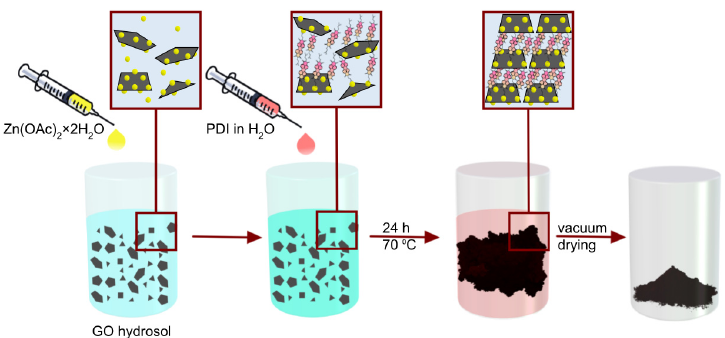
Figure 2. Schematically illustrated fabrication procedure for the formation of GO/Zn (OAc) 2 /PDI hybrid materials.